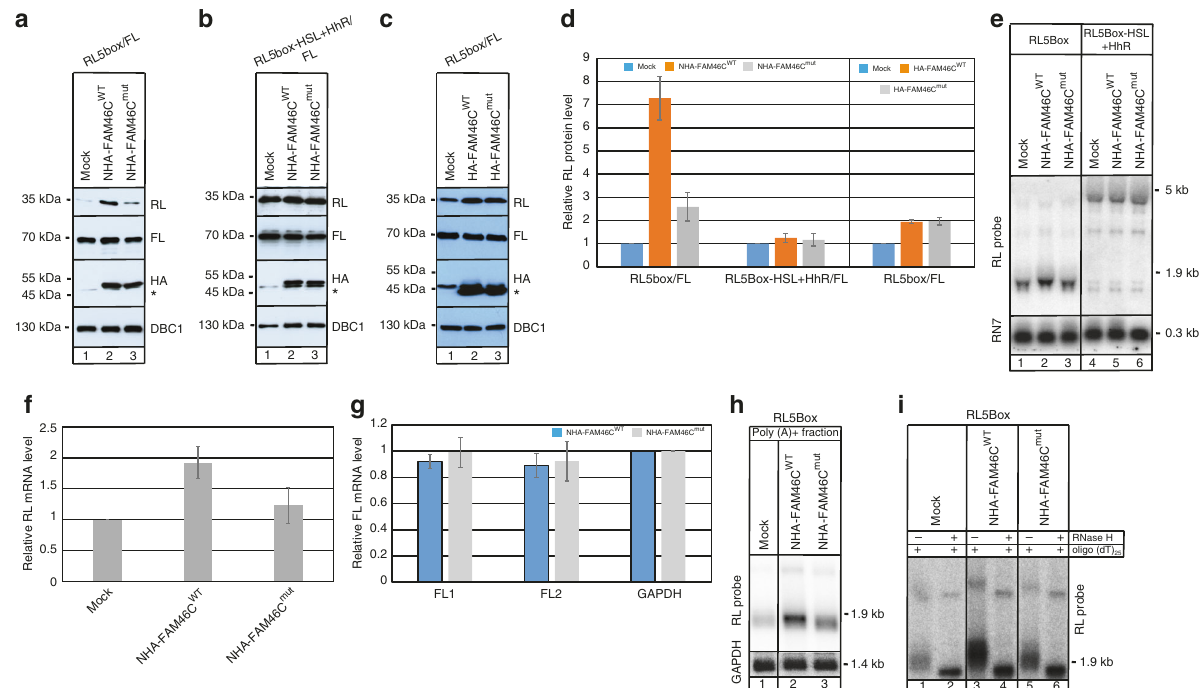
Fig. 3 FAM46C tethering leads to polyadenylation and enhanced expression of a Renilla luciferase (RL) reporter. Analysis at the protein level ( a – d ): a FAM46C tethering increases RL reporter protein levels. HEK293 cells were co-transfected with a construct expressing RL, containing fi ve boxB sites in its 3 ′ -UTR, Fire fl y luciferase (FL) control reporter and FAM46C WT harboring the N-terminal λ N boxB-binding domain and HA-tag. Western blot detection of RL in mock-transfected cells (lane 1) and after NHA-FAM46C WT (lane 2) or NHA-FAM46C mut (lane 3) tethering. Expression of NHA-tagged FAM46C proteins were con fi rmed using an α -HA antibody. DBC1 served as a loading control. Asterisks indicate cross-hybridization signals. b Expression of RL5boxHSL + HhR reporter with a cyclic phosphate at the 3 ′ end generated by a hammerhead ribozyme was not enhanced upon FAM46C tethering. The experiment was performed as in a . c Expression of the FAM46C without λ N domains did not enhance expression of the reporter. The experiment was performed as in a . d Quanti fi cations of RL protein normalized by the internal FL reporter related to experiments from a – c . RNA analysis ( e – i ): e northern blot detection of RL mRNA using total RNA from HEK293 cells after tethering of NHA-FAM46C WT or NHA-FAM46C mut to RL5box (lanes 1 – 3) or RL5boxHSL + HhR with a cyclic phosphate at the 3 ′ end (lanes 4 – 6). f Quanti fi cations of RL mRNA. g RT-qPCR analysis of the FL control reporter. h Northern blot detection of Renilla luciferase using poly(A) + fraction from HEK293 cells after tethering of NHA-FAM46C WT or NHA-FAM46C mut ( i ) Poly (A) tails added to reporter mRNA can be removed by RNase H treatment in the presence of oligo(dT) 25 . High-resolution northern blot analysis of RL mRNA from control HEK293 cells (lanes 1 – 2), after tethering of NHA-FAM46C WT (lanes 3 – 4) or NHA-FAM46C mut (lanes 5 – 6). The data in d , f , g are shown as a mean value ± SD ( n =